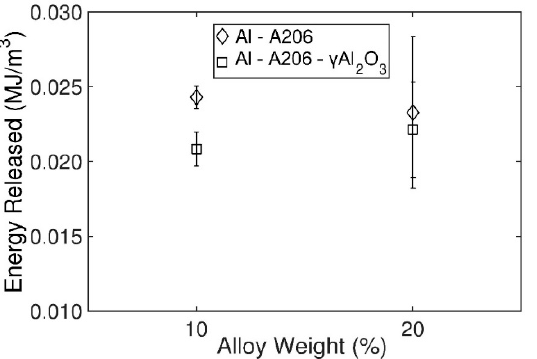
Figure 15. Energy released during the PLC phenomenon at a 0.125 mm/min strain rate.